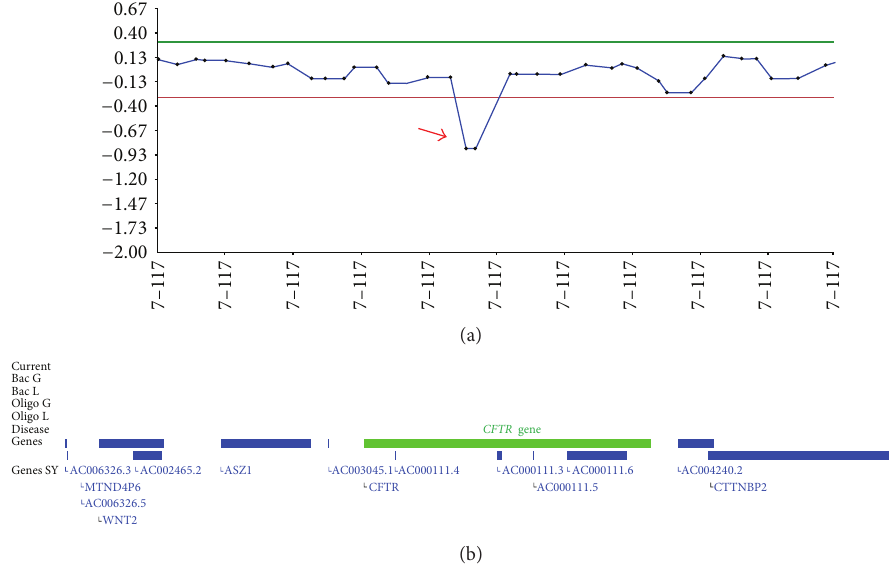
Figure 1: Array-CGH profile from the patient using Cytochip ISCA 180K Oligo platform (BlueGnome Ltd.) showing a subtle deletion (red arrow) of two oligonucleotides within the CFTR gene. Image from BlueFuse v3.2 (BlueGnome Ltd.)